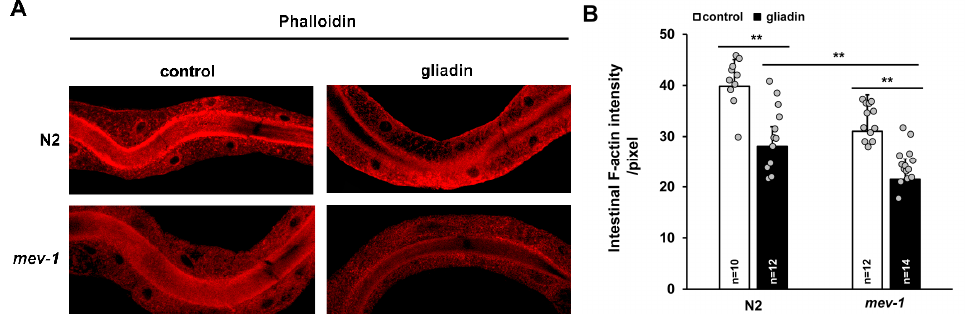
Figure 4. Effects of gliadin treatment on intestinal F-actin in adult-stage wild-type N2 and mev-1 mutant C. elegans worms. ( A , B ) Wild-type N2 and mev-1 mutants synchronized at the L4 larval stage were treated with or without gliadin. Detection of phalloidin staining of intestinal F-actin reveals a significant reduction in fluorescence after gliadin treatment in either N2 and mev-1 mutants based on quantification by image J analysis ( B ). Error bars represent s.d. ** p < 0.005 (Student’s t -test).